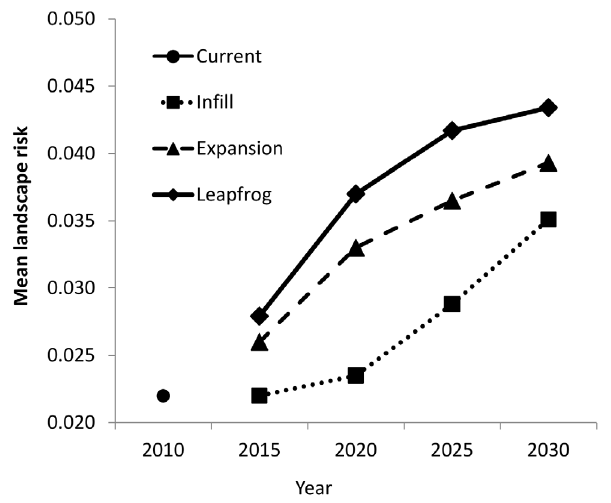
Figure 5. Projected landscape fire risk, reflecting the proba- bility of burning in a wildfire averaged across all residential structures on the current landscape and in three development scenarios of infill, expansion, and leapfrog for year 2030.